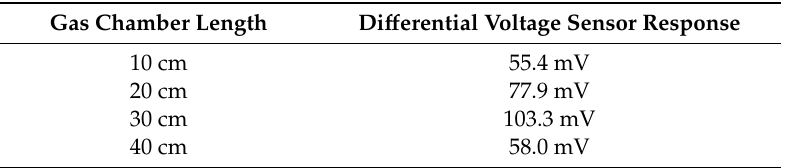
Table 2. Di ff erential voltage sensor response to 1000 ppm carbon